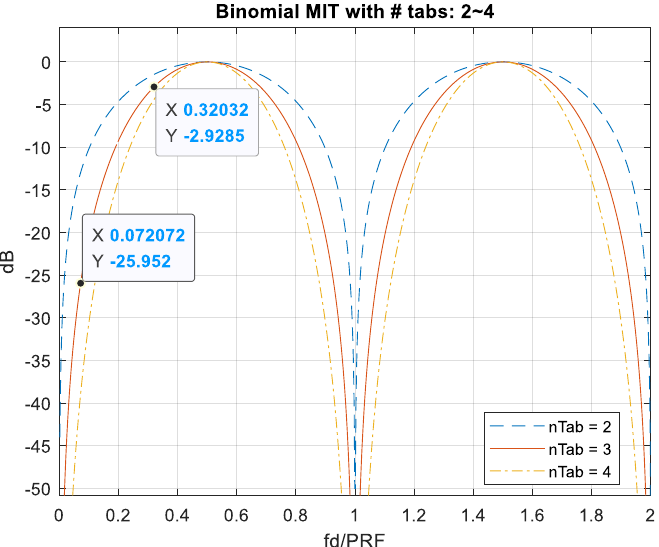
Figure 19. Frequency response of MTI comb filters applied binomial coefficients with the number of integrating pulses from two to four. The cut-off bandwidths are proportional to the number of delay lines applied.